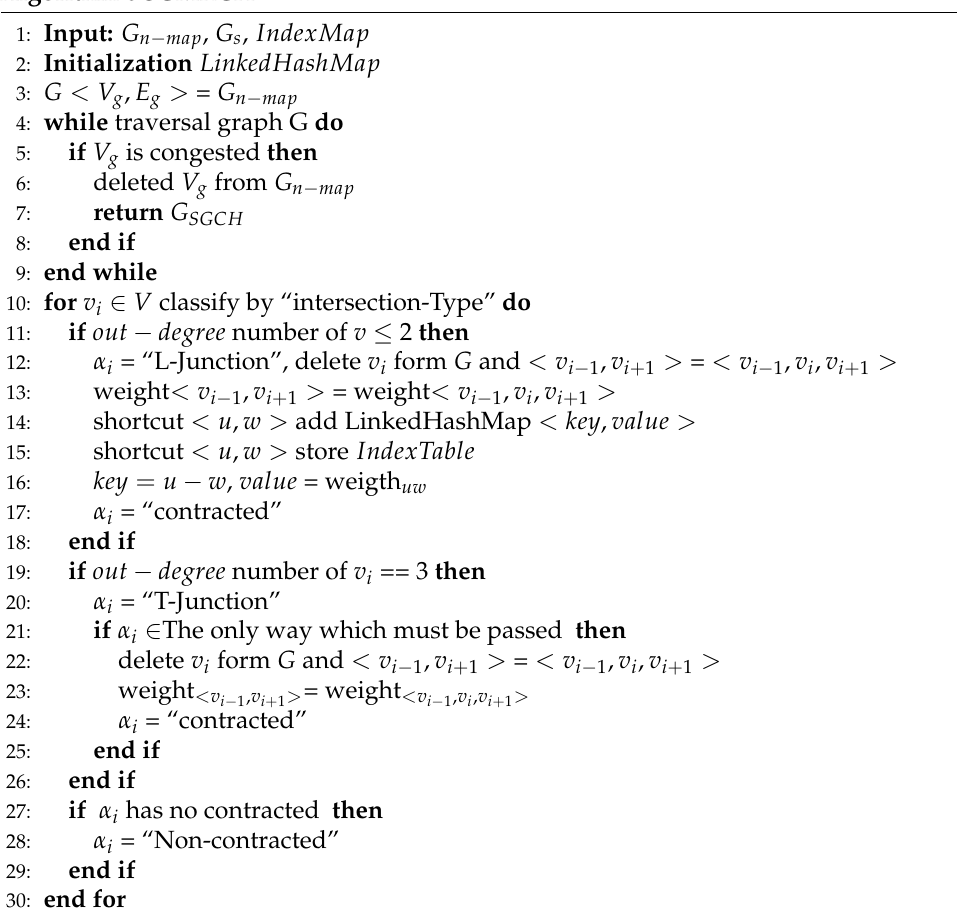
Algorithm 6 SGMRCH